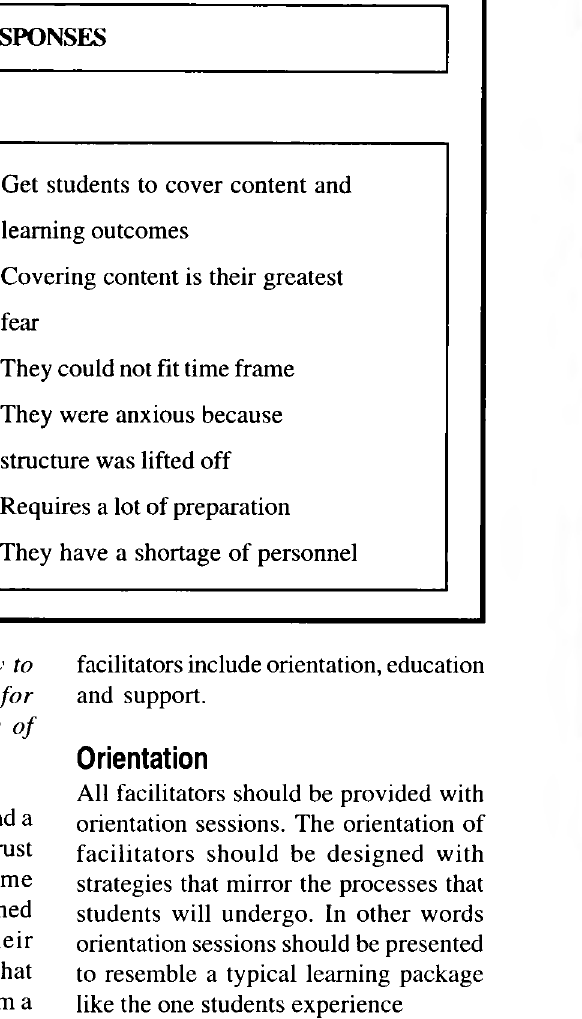
FIGURE 1.6: Challenges/fears of facilitation process